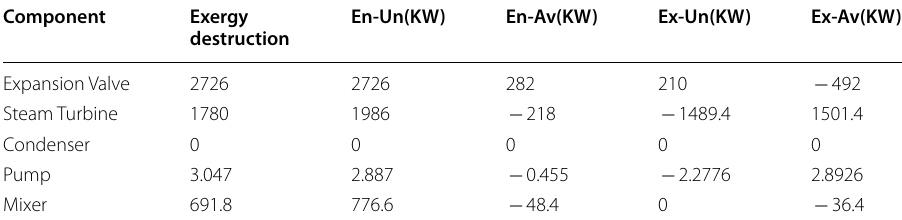
Table 7 Separation of endogenous and exogenous exergy degradation cycle of the cycle into avoidable and unavoidable